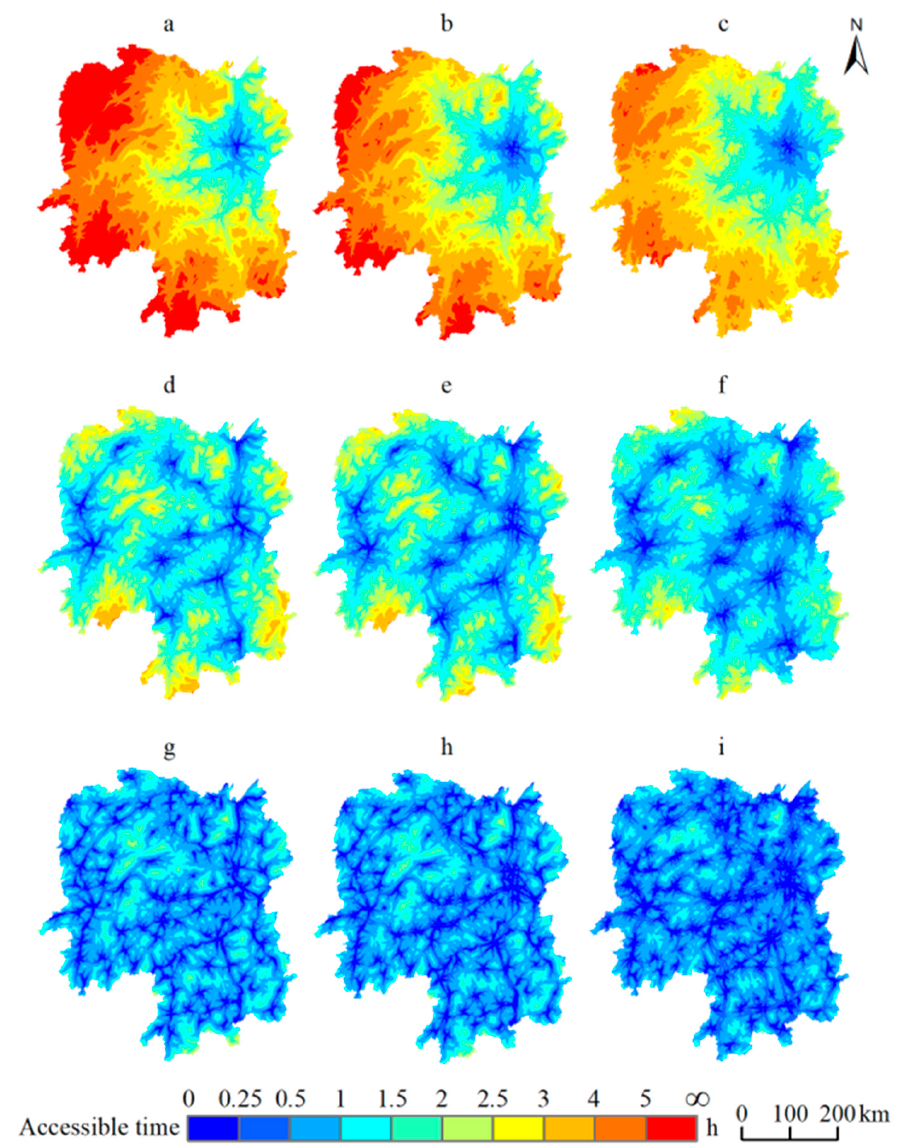
Figure 3. Traffic accessible time on multiple administrative levels in Hunan province: ( a – c ) are ac- cessibility to mega-cities in 1995, 2005, and 2015; ( d – f ) are accessibility to prefecture-level cities in 1995, 2005; and 2015, and ( g – i ) are accessibility to county-level cities in 1995, 2005, and 2015.